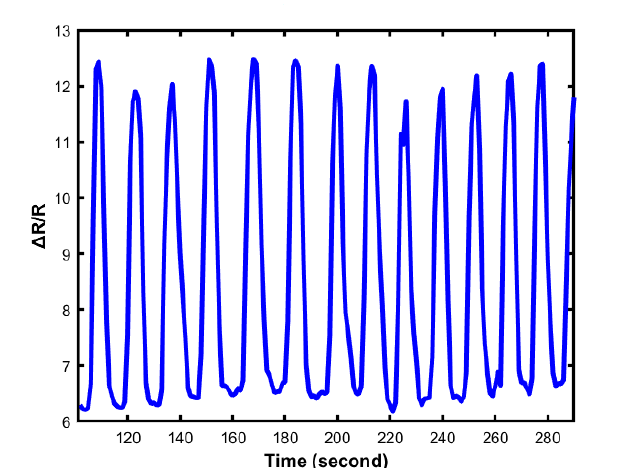
Figure 11. One thousand episodes of cyclic loading and unloading tests at 30 kPa (300 s period).